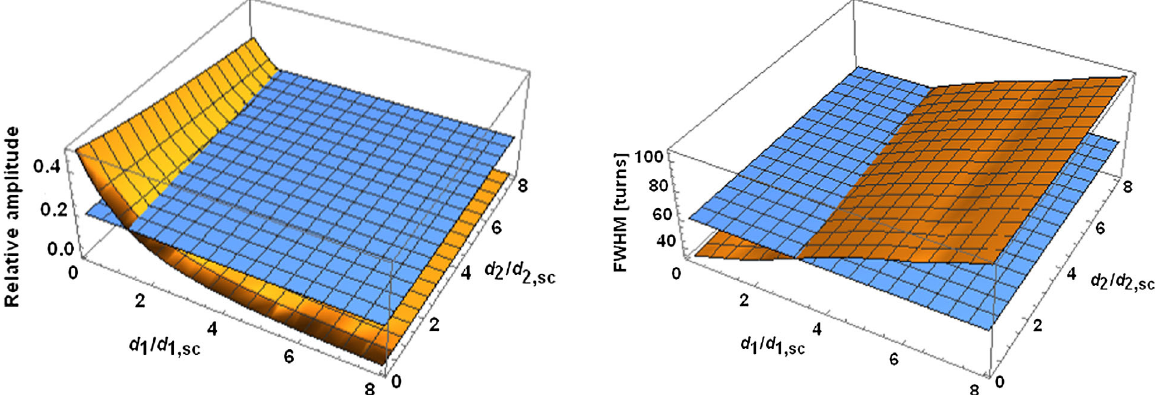
FIG. 8. Left: Relative echo amplitude (in brown) as a function of the scaled diffusion coefficients d 1 =d 1 ;sc and d 2 =d 2 ;sc intersected by a plane (in blue) of a particular relative amplitude value, here chosen to be 0.2. The intersection defines the family of solutions for ð d 1 ; d 2 Þ at this amplitude. Right: The FWHM (in brown) as a function of the same scaled variables and the plane (in blue) at a constant FWHM, here chosen to be 60 turns. Again, the intersection defines the family of solutions for the FWHM equation.